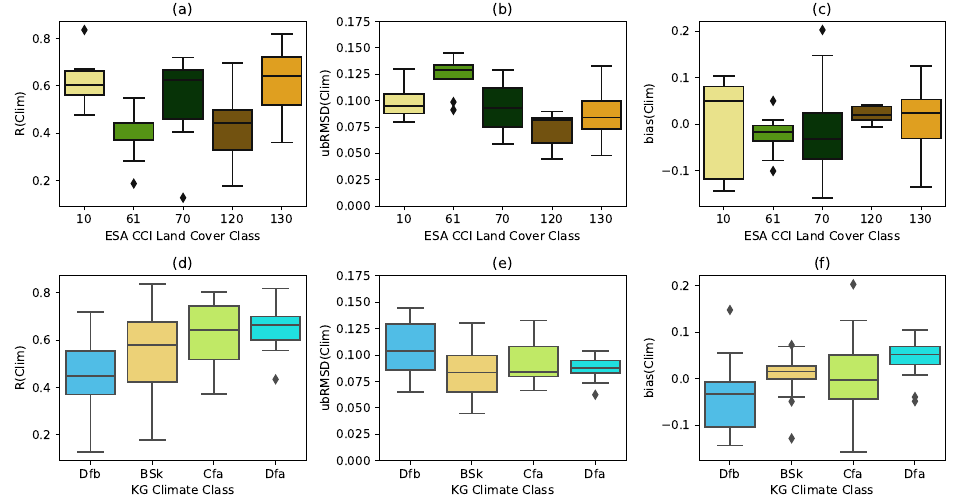
Figure 5. Box plots of the Pearson correlation coefficient (R), unbiased RMSD and bias between in situ soil moisture and soil moisture retrieved using vegetation parameters derived from climatological values, sorted by ESA CCI Land Cover Class ( a – c ) and Köppen–Geiger Climate Class ( d – f ). The box extends from the lower to upper quartile values of the data, with a line at the median. The lower whisker is at the lowest datum above Q1 − 1.5 ∗ (Q3 − Q1) and the upper whisker at the highest datum below Q3 + 1.5 ∗ (Q3 − Q1), where Q1 and Q3 are the first and third quartiles. Outliers are indicated as diamonds.